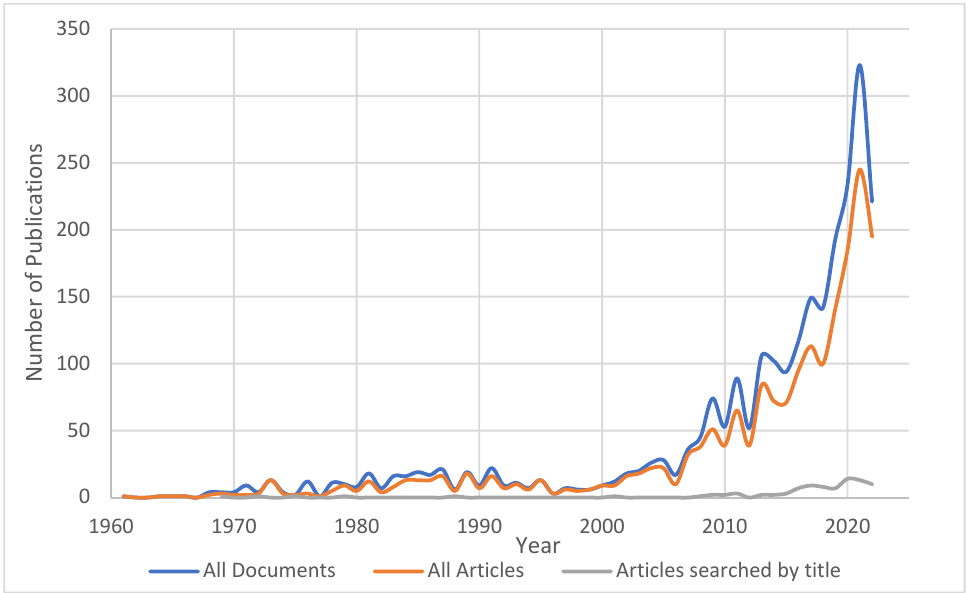
Figure 1. The number of documents published for keywords (desalination or “solar still”) and (CFD or “computational fluid dynamic*” or radiation) or “Solar Intensity”.